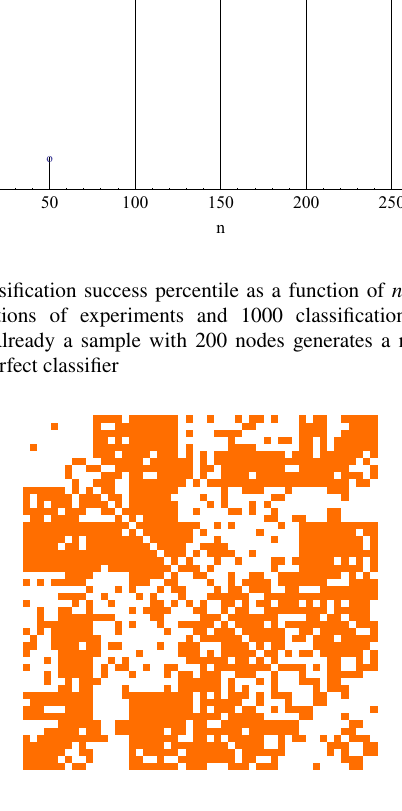
Fig. 6 A sample graph with 50 nodes that is insufficient to create a successful classifier—the result is similar to completely random clas- sification